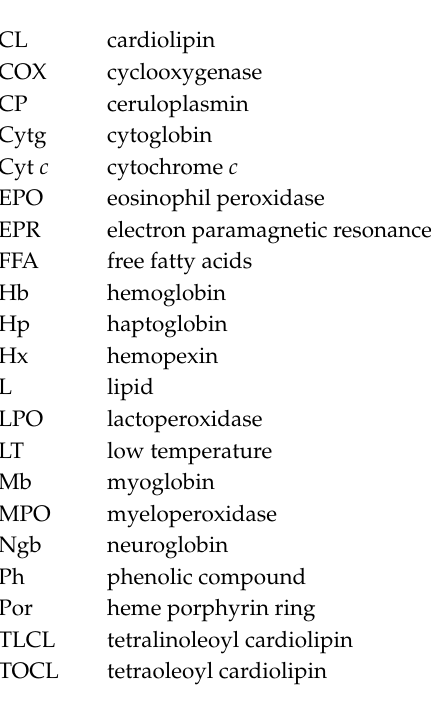
Low-temperature EPR spectra of high spin ferric heme and protein-based radicals of pseudo-peroxidases, Figure S3: Phenolic compounds—peroxidase substrates, Figure S4: CO binding to Cyt c depends on cardiolipin